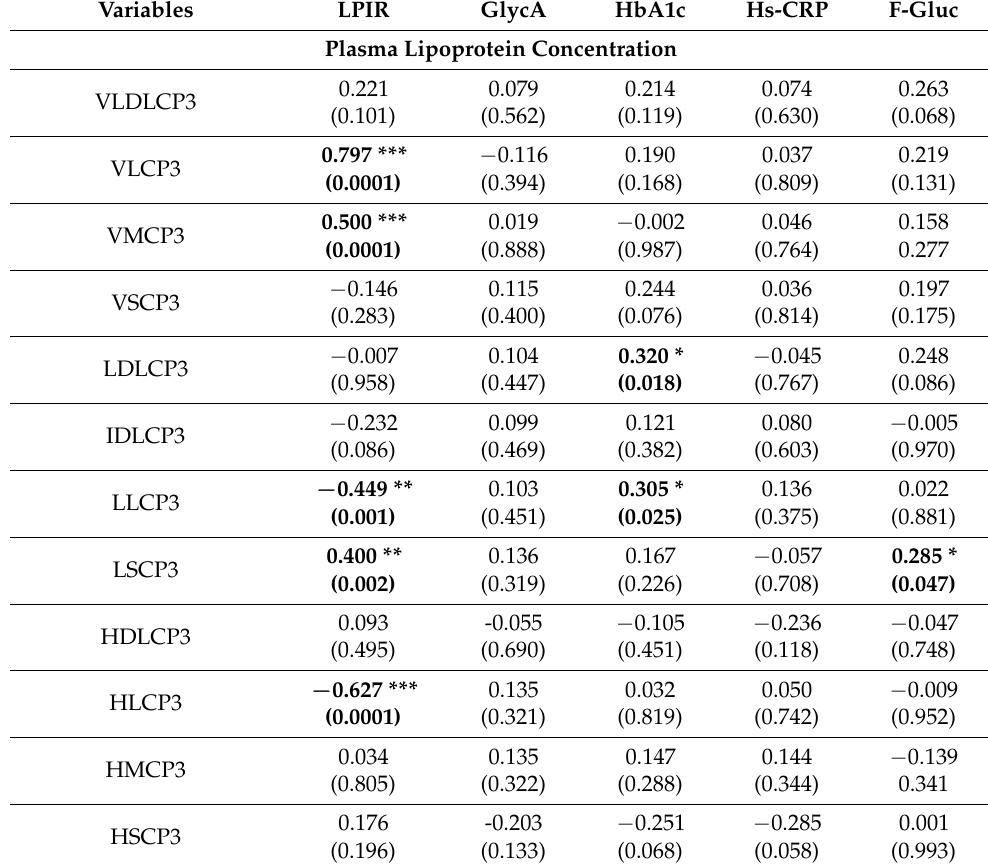
Table 4. Spearman correlation analysis between plasma lipids and lipoproteins subpopulations with insulin resistance and inflammation markers in T2DM